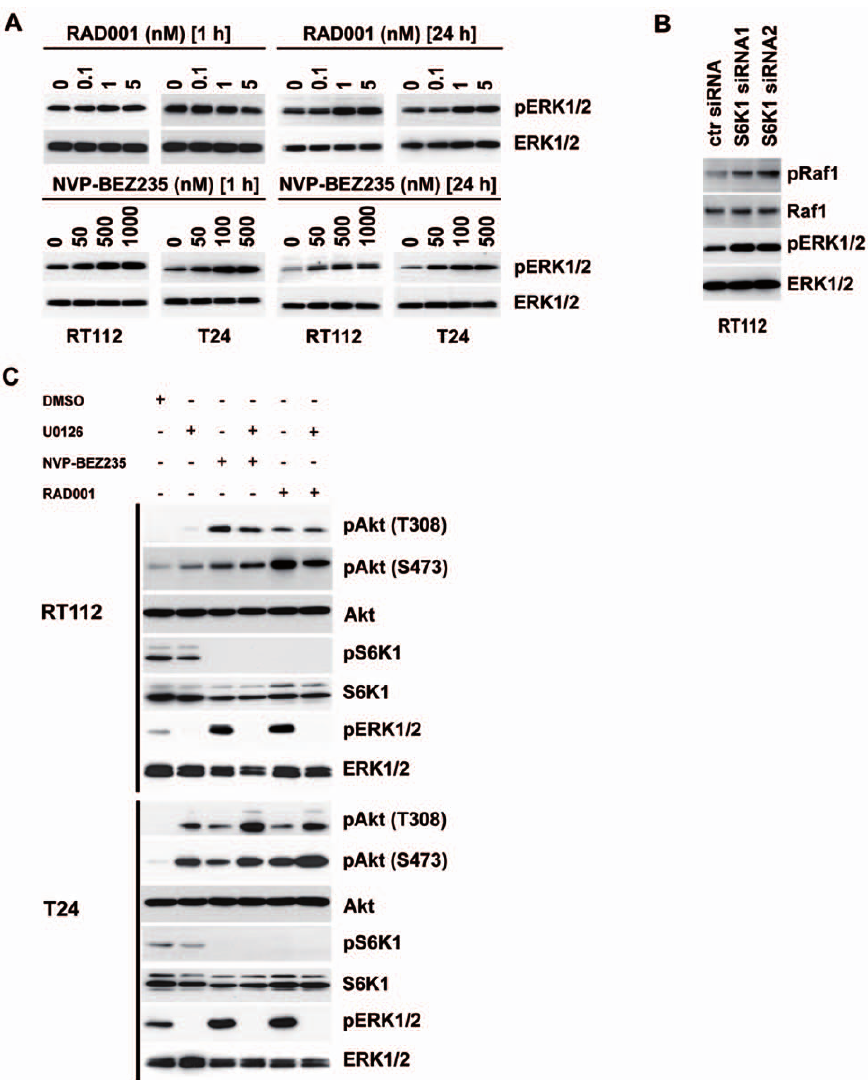
Figure 4. Crosstalk between the PI3K and MAPK signaling pathways. A: RT112 and T24 cells were treated with RAD001 or NVP-BEZ235 for 1 h or 24 h. Expression and phosphorylation status of ERK1/2 was analyzed in immunoblots on whole cell lysates. B: Two days after transfection with siRNA oligonucleotides against S6K1 or control siRNA (ctr siRNA), cells were lysed and phosphorylation and expression status of Raf and ERK1/2 was analyzed in immunoblots. C: Cells were treated for 24 h with RAD001, NVP-BEZ235 and U0126 alone or in combination and effects on expression and phosphorylation level of Akt, S6K1 and ERK1/2 was analyzed in immunoblots.